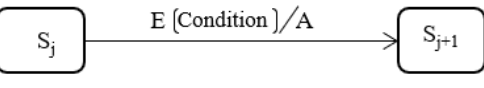
Figure 1. Visual syntax of state transition diagram.